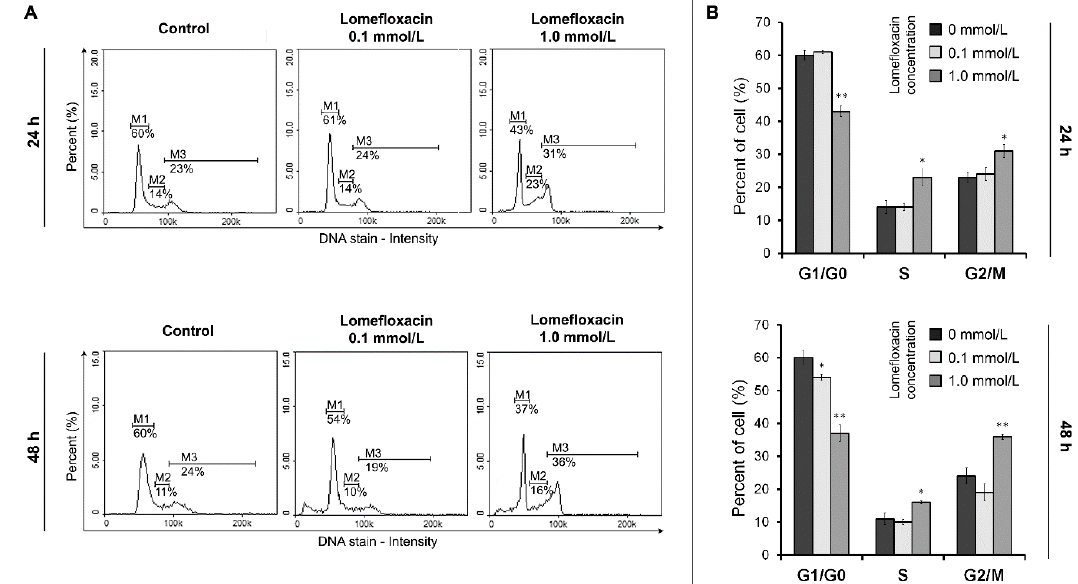
Figure 5. Cell cycle analysis of COLO829 cells exposed to lomefloxacin. ( A ) Histograms presenting the cell cycle distribution in cells exposed to lomefloxacin in concentrations of 0.1 and 1.0 mmol/L for 24 and 48 h. The presented histograms are representative of three independent experiments with similar results. The effect of the drug on the cell cycle distribution was investigated by a fluorescence image cytometer after DAPI (4 ′ ,6-diamidino-2-phenylindole) staining. M1G 1 /G 0 phase; M2—S-phase; M3—G 2 /M phase. ( B ) The effect of lomefloxacin on the cell cycle distribution in COLO829 cells. The cells were treated with lomefloxacin at concentrations of 0.1 and 1.0 mmol/L for 24 and 48 h. Mean values ± SEM from three independent experiments ( n = 3) performed in triplicate are presented. * p < 0.05 versus control samples; ** p < 0.005 versus control samples.